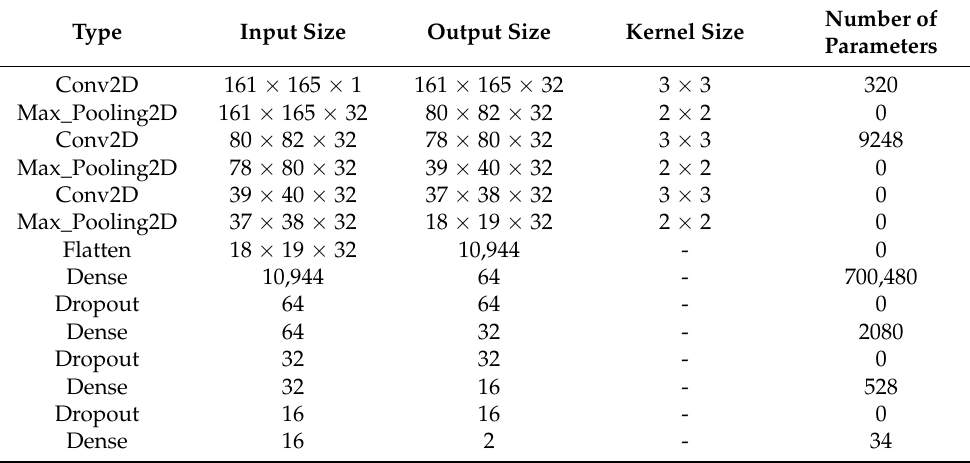
Table 3. Architecture of the convolutional neural networks designed.